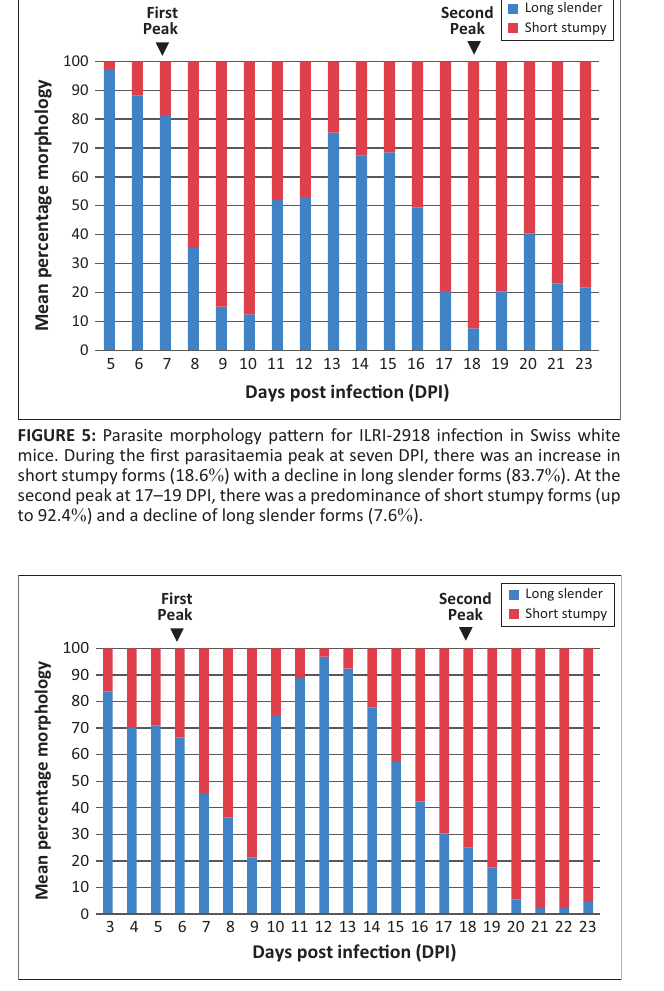
FIGURE 6: Parasite morphology pattern for IPR-001 infection in Swiss white mice. During the first peak at six DPI, there was a notable increase in the number of short stumpy trypomastigotes (33.6 % ) and a decline in the long slender forms (66.4 % ) compared to the populations at the beginning of the observation period. At the second peak at 18 DPI, there was a predominance of short stumpy forms (74.9 % ) and a decline of long slender forms (25.1 % ).